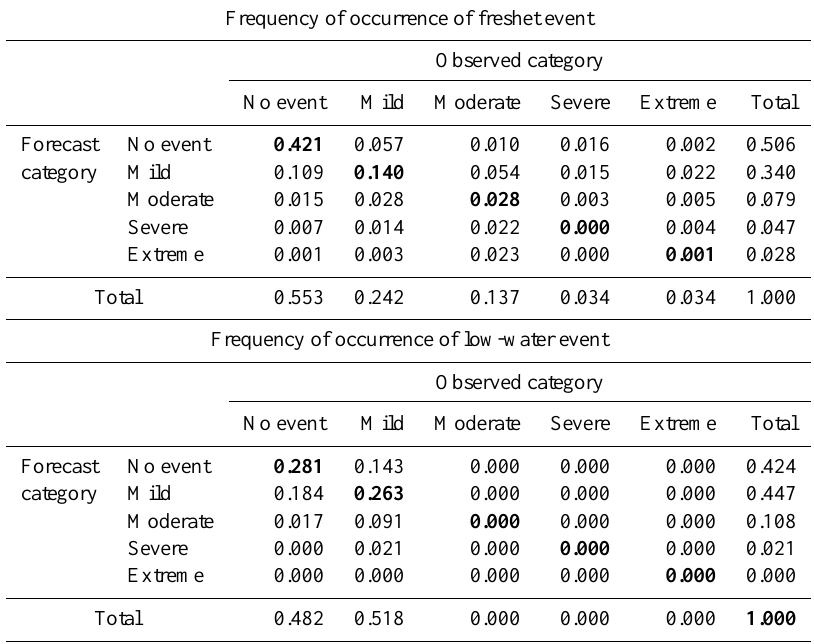
Table 2. Multi-Category Contingency Table of the Ensemble Event Forecasts (diagonal (bold) elements denote frequencies of the forecasted events of the specific category that meet the observed events in the same